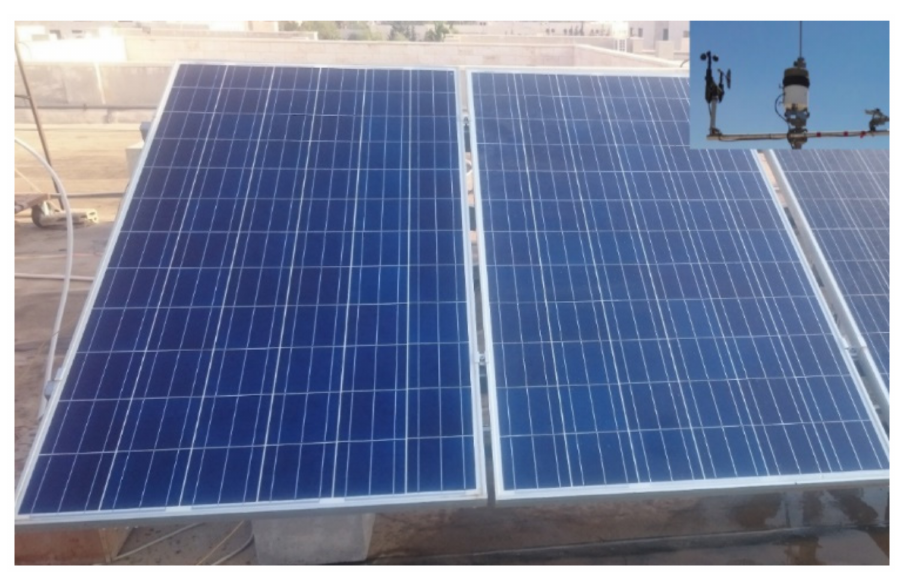
Figure 7. Solar Panels—YL300P-35P. Table 3. PV module specifications—Polycrystalline Si. PV Module—Polycrystalline